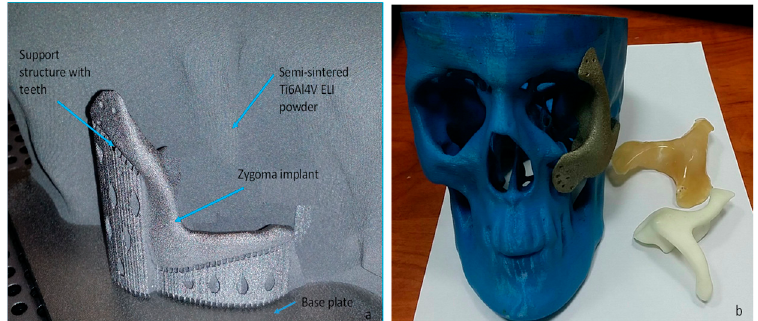
Figure 8. ( a ) EBM fabricated titanium zygomatic implant with support structures inside the powder recovery system and ( b ) titanium zygomatic implant fitted to the skull model after support removal.